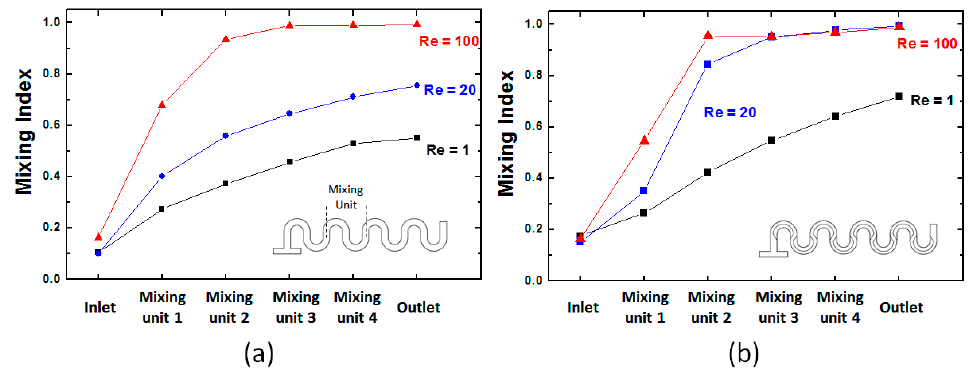
Figure 7. Position dependence of the mixing index along serpentine micromixers at different Reynolds numbers: ( a ) a standard serpentine microchannel and ( b ) a modified channel.